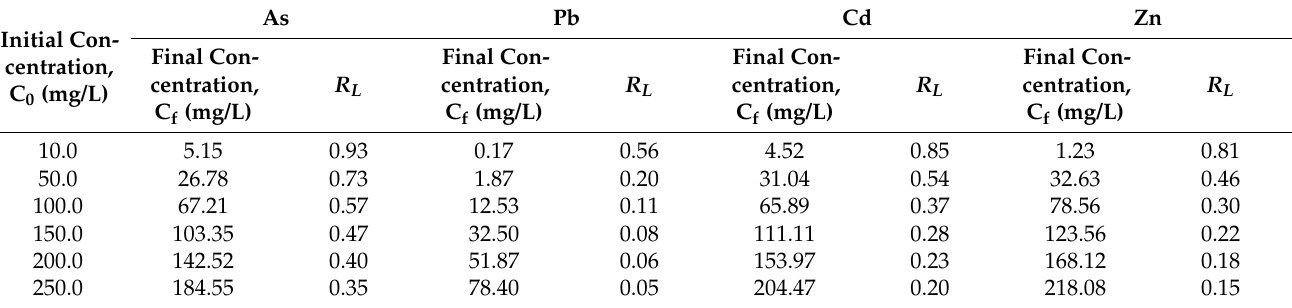
Table 6. RL values for adsorption evaluated through the Langmuir